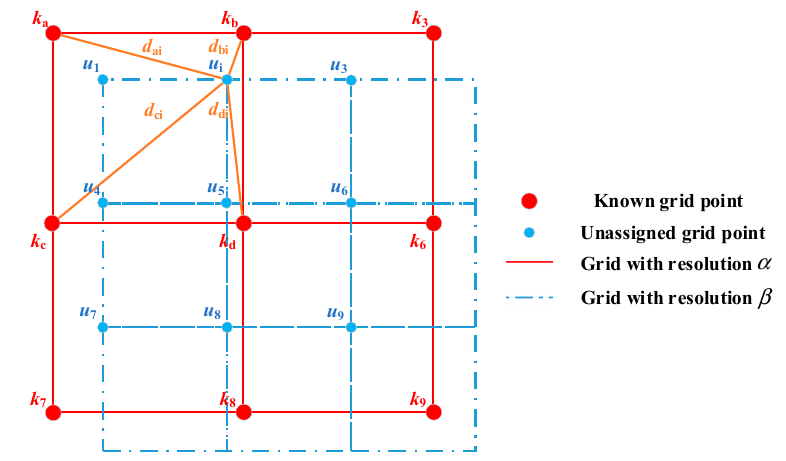
Figure 2. Schematic diagram of accurate and meticulous interpolation of grid data.